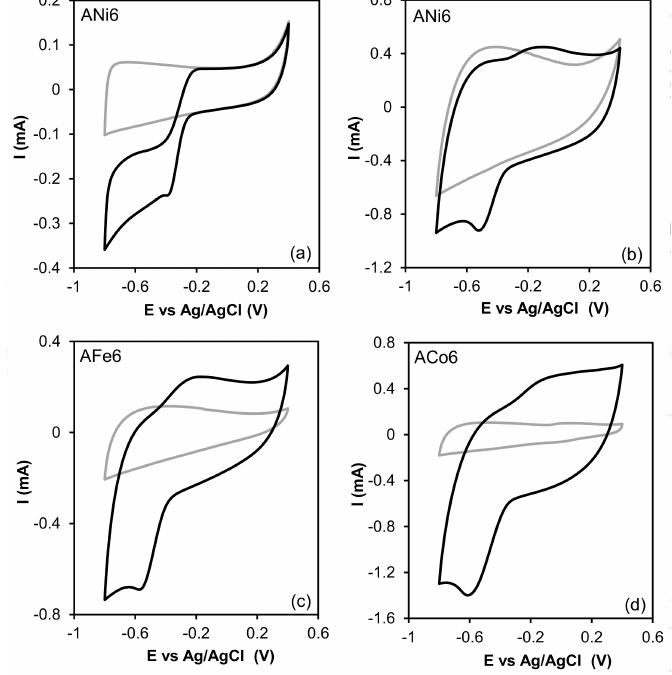
Figure 8. Cyclic voltammetries on N 2 -saturated KOH 0.1 M (grey) and O 2 -saturated KOH 0.1 M (black).